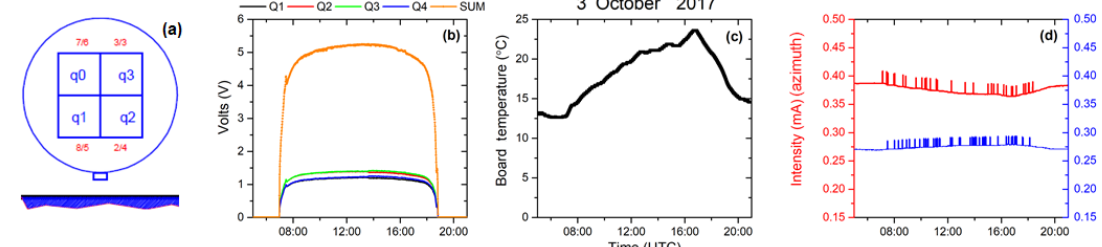
Figure 5. Daily control test of the Owel INTRA solar tracker at IZA. (a) Front view of the quadrants of the Sun detector. The numbers indicated are pins of the sensor/connector, respectively; (b) Sun-sensor signals in the four quadrants and the total signal from the quadrants; (c) board temperature ( ◦ C); and (d) current from base shunt of motor0 driver (azimuth axis, mA) (red color) and current from base shunt of motor1 driver (elevation axis, mA) (black color) (INTRA, 2010).